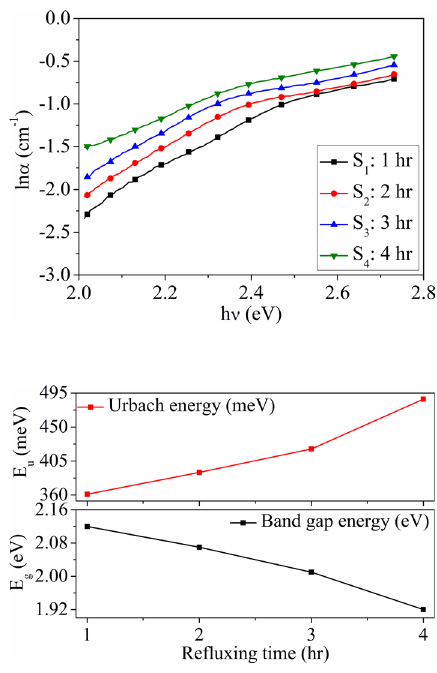
Fig. 5 The plot of lnα versus hυ of CdTe QDs for the sam- ples: S –S 1 4